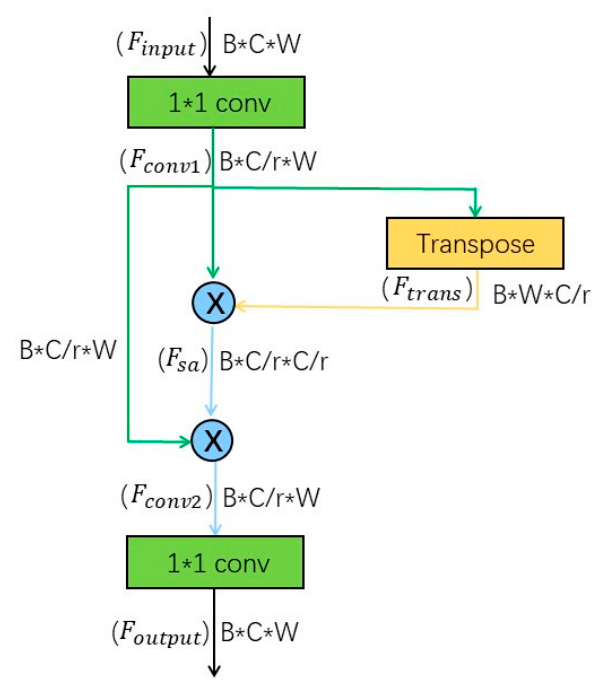
Figure 3. Self-attention Figure 3. self-attention module.